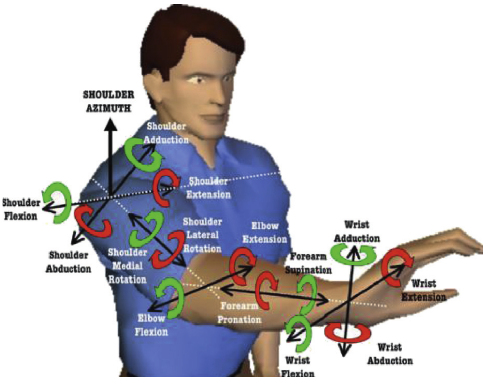
Figure 5: Conventional primary 7 DoF(s) of the human-exo- skeleton arm